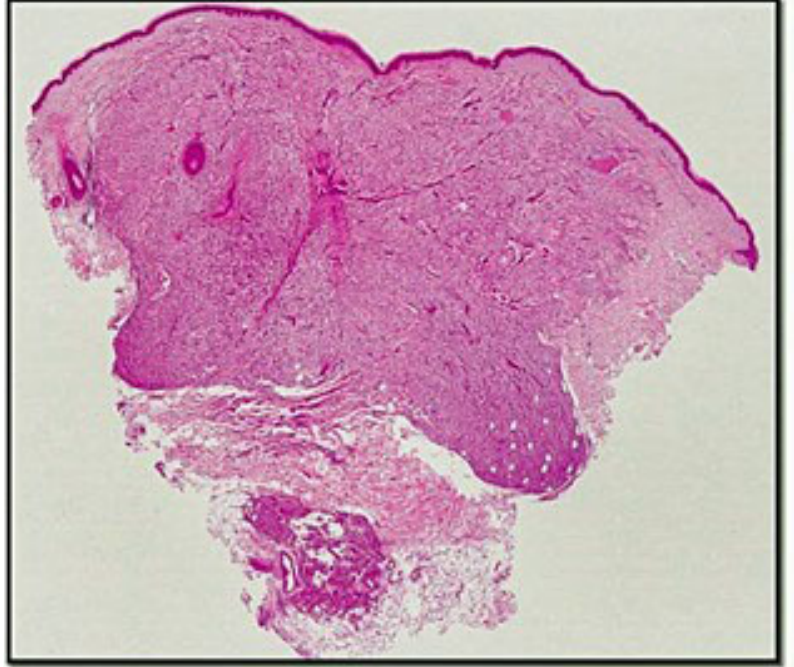
Figure 1. Histological micrograph showing a dermal, clear cell lesion infiltrating the subcutis at one point (hematoxylin–eosin, original magnification: 4×). Black arrow indicates the adipocytic lobules of the subcutis buried by the infiltration of the lesion.